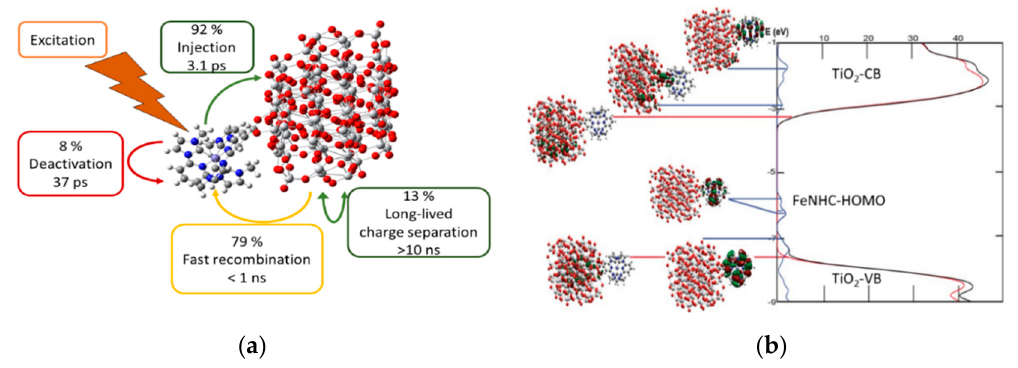
Figure 13. ( a ) Measured interfacial injection dynamics of complex 5 sensitized to a surface of nano-TiO 2 according to results from Harlang et al. [85], and ( b ) associated calculated interfacial electronic structure properties. Adapted with permission from Fredin et al. [86], published 2016 with copyright by Wiley.